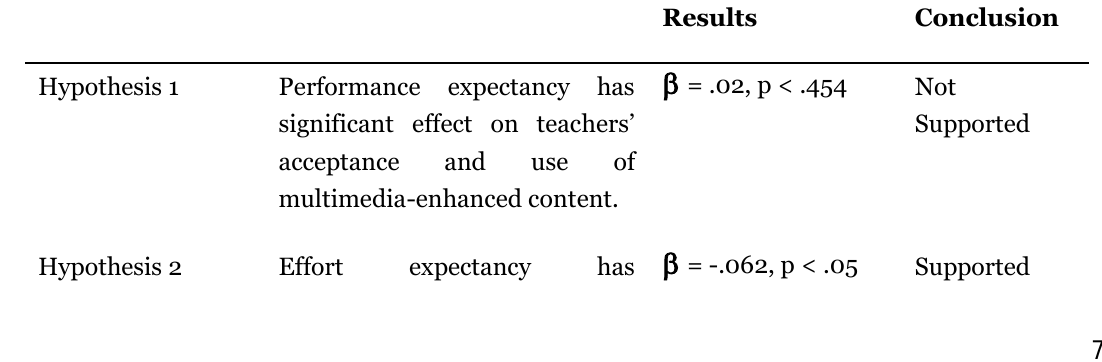
Summary of Results Hypothesis